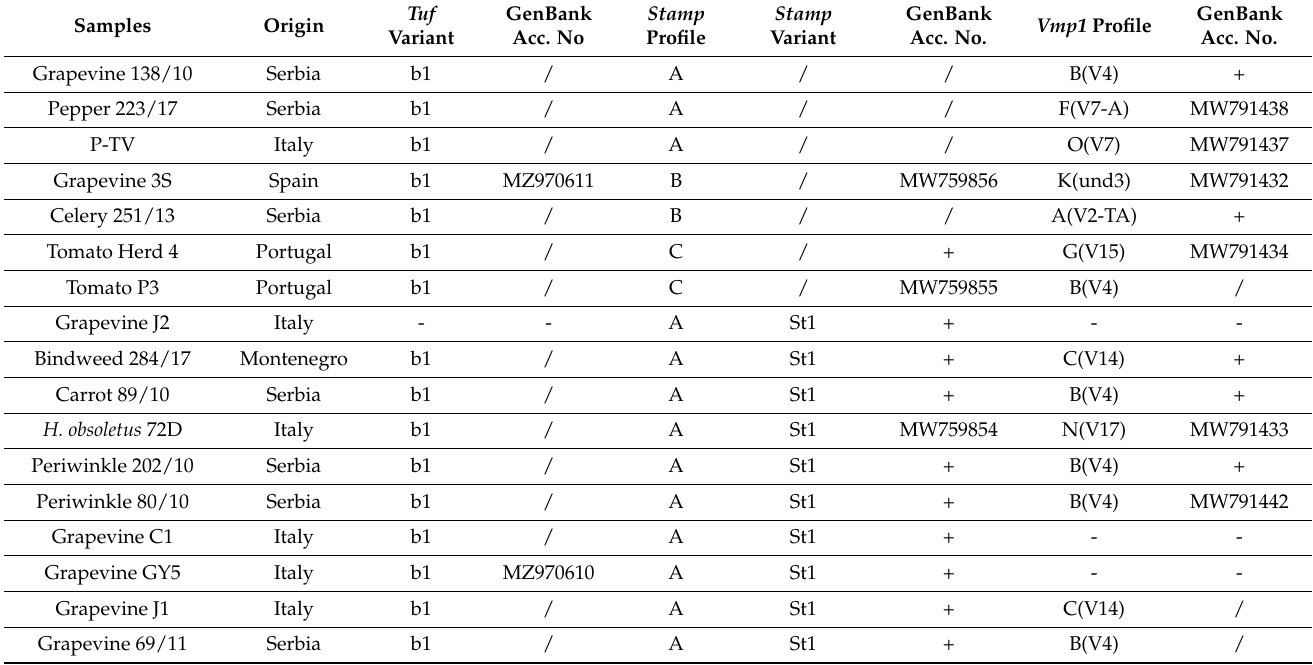
Table 3. Samples sequenced and used for the phylogenetic